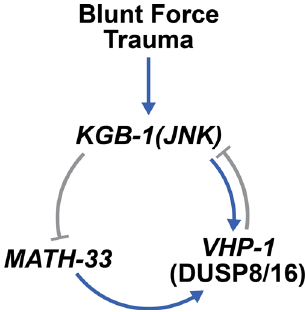
Fig. 8 Dual feedback governs transcriptional and post-translational regulation of VHP-1. Mechanical stress via blunt force trauma activates KGB-1, which leads to the transcriptional upregulation of vhp-1 and repression of math-33 . VHP-1 is stabilized by MATH-33 and, in turn, represses KGB-1